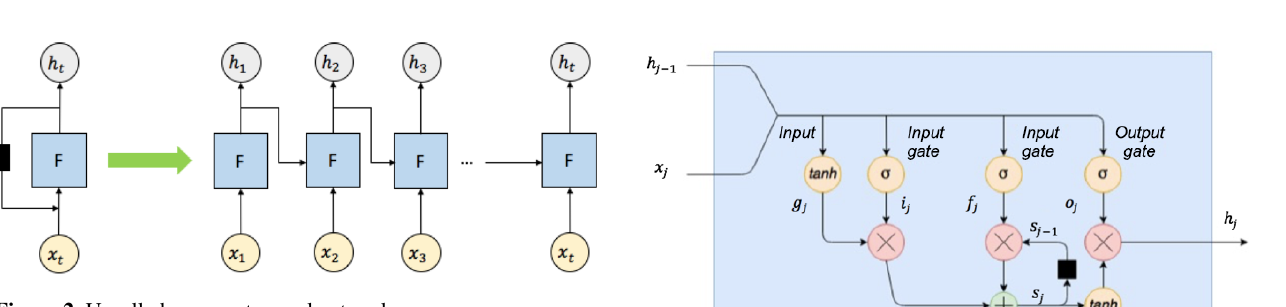
Figure 2. Unrolled recurrent neural network.